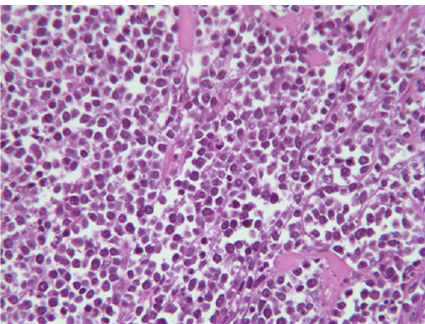
Figure 5: Pathology of tumour specimen instead of biopsy of the tumour anatomopathology (HE—400x): intermediate size homogenous basophilic cells with hyperchromatic nuclei contain- ing nucleoli: Burkitt’s